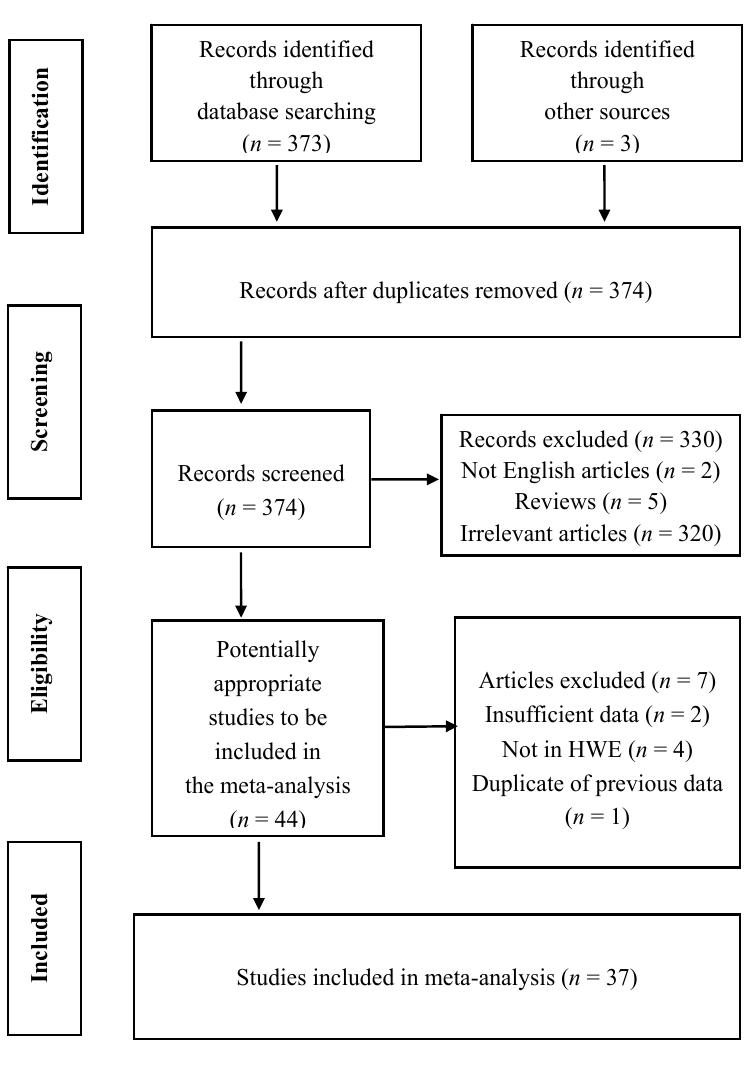
Figure 1. Flow diagram of study